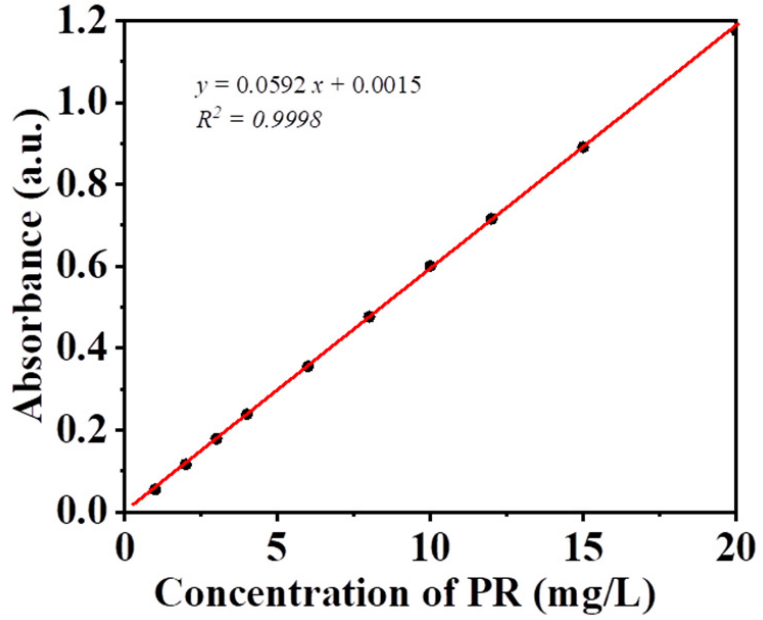
Figure 2. Standard curve for determination of PR concentration in water.